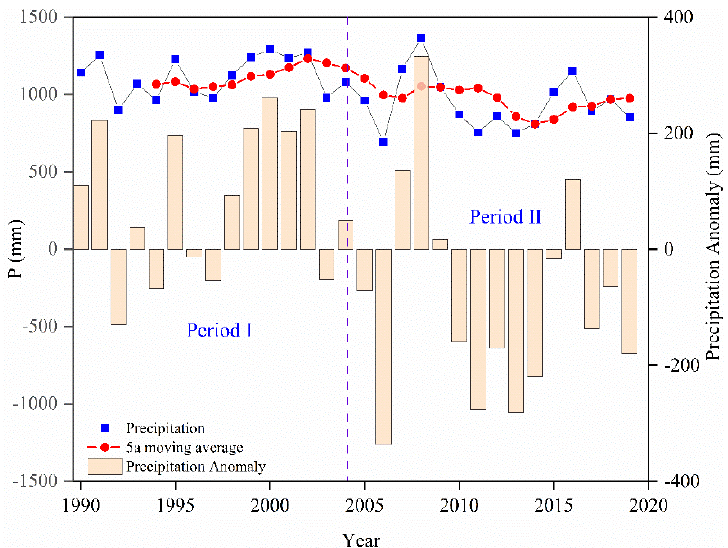
Figure 3. Interannual precipitation changes in the Erhai Basin. Period I represent 1990–2004, and period II represent